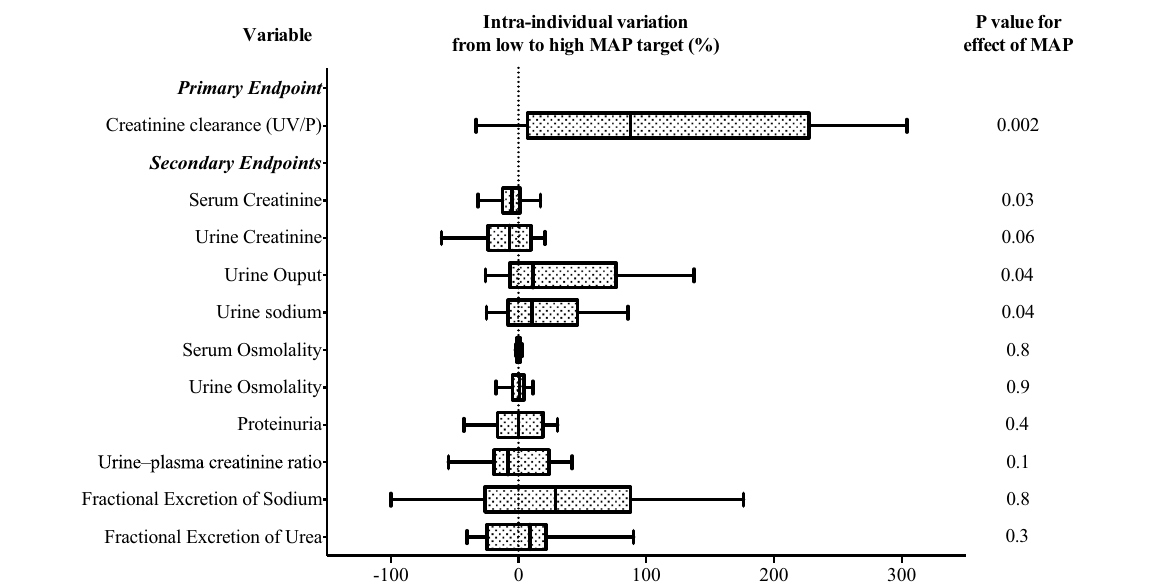
Fig. 4 Primary and secondary endpoints. Intra‑individual variations in blood and urine parameters from low to high‑MAP target period, expressed as a percentage. GFR was estimated by the UV/P (Creatinine Clearance). P values for the within‑subject comparison of MAP using a multivariate repeated‑measures analysis of variance